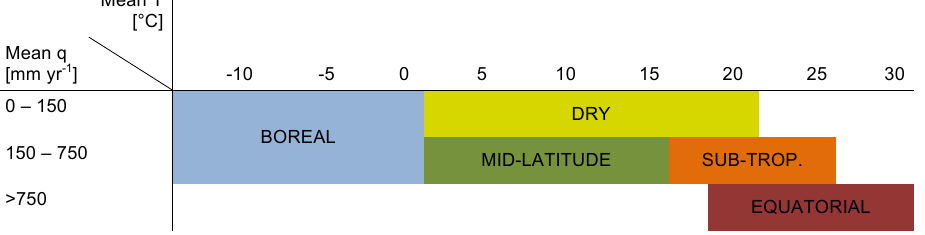
Table 1. Target limits of annual average temperature (T) and runoff (q) for aggregated river basins defining hydrobelts.